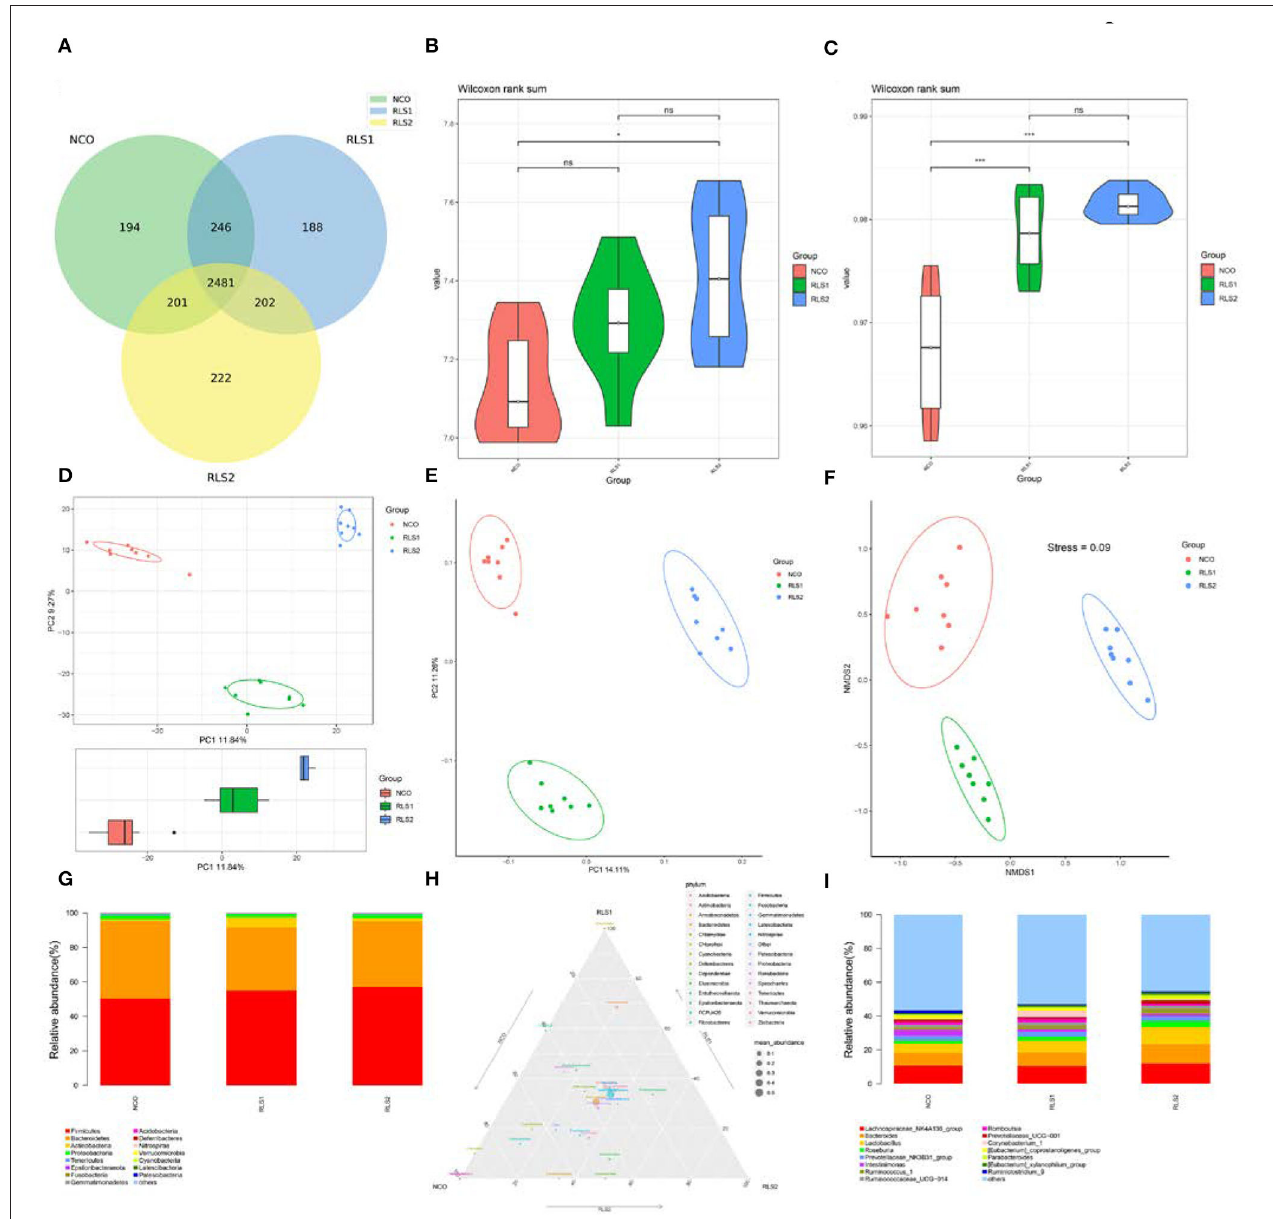
FIGURE 5 | Effects of RLS on the colonic microflora in rats. NCO, rats were gavage-fed normal saline; RLS1, rats were gavage-fed 10mg RLS / 200g body weight; RLS2, rats were gavage-fed 20mg RLS / 200g body weight. (A) Venn diagram. (B) Shannon index. (C) Simpson index. (D) Principal component analysis (PCA). (E) Principal coordinate analysis (PCoA). (F) Non-metric multidimensional scaling (NMDS). (G) The microbiota composition at phylum level. (H) Ternary phase diagram of the dominant phyla. (I) The microbiota composition at genus level. Data are shown as mean ± SEM and analyzed by one-way ANOVA LSD test ( n = 8 in each group). * represents P < 0.05, *** represents P < 0.001, ns represents